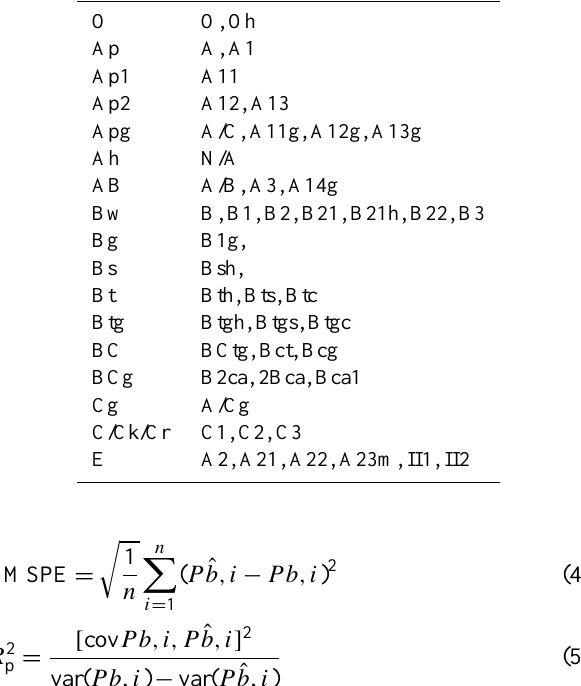
Table 1. Irish SIS horizon designations used in this study and equiv- alent horizon titles used in the national soil survey by An Foras Talúntais. Irish